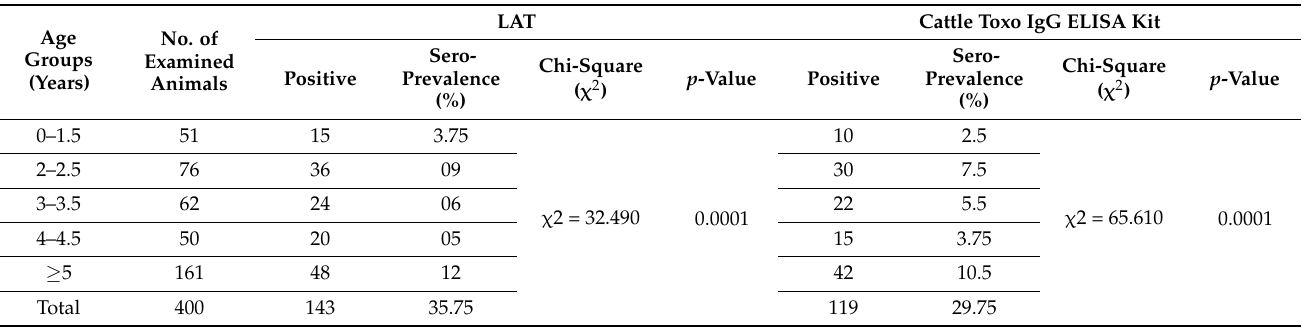
Table 10. Serological investigation of T. gondii antibodies in exotic cattle by LAT and Cattle Toxo IgG ELISA